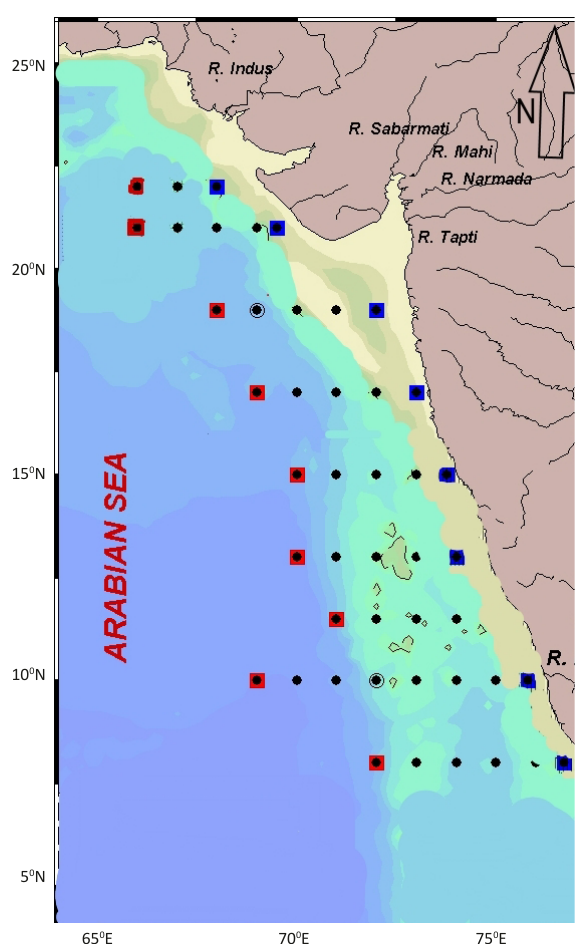
Figure. 1 Station locations in the Arabian Sea indicating the oceanic stations (Red square) and coastal stations (Blue